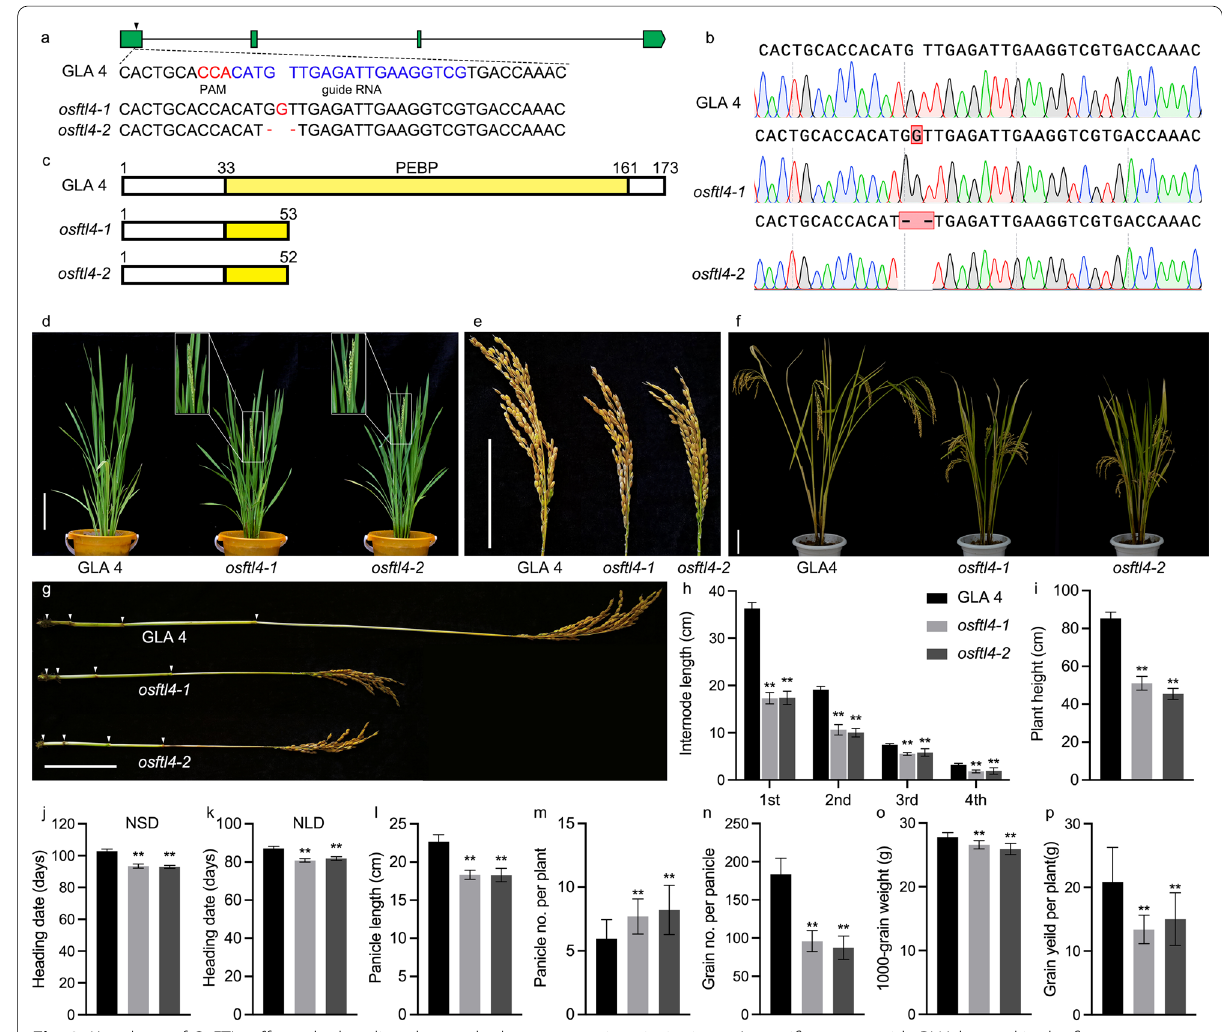
Fig. 2 Knockout of OsFTL4 affects the heading date and other agronomic traits in rice. a A specific target guide RNA located in the first exon was used to edit OsFTL4 via the CRISPR/Cas9 system. The PAM region and guide sequence are marked in red and blue, respectively. The OsFTL4 mutation sites in the two mutants ( osftl4-1 and osftl4-2 ) are indicated. b Mutations were confirmed by sequencing. Mutated bases are marked with red boxes. c OsFTL4 protein structures in GLA 4, osftl4-1 , and osftl4-2 . The PEBP domain is marked in yellow. d Morphology of GLA 4, osftl4-1 , and osftl4-2 plants at heading stage. Scale bars, 10 cm. e Panicle phenotype of GLA 4, osftl4-1 , and osftl4-2 . f Morphology of GLA 4, osftl4-1 , and osftl4-2 plants at maturity satge. Scale bars, 10 cm. g Panicle and internode at maturity. Scale bars, 10 cm. h Length of four internodes below the spike. Heading date for GLA 4, osftl4-1 , and osftl4-2 in Lingshui j and Yangzhou k . Comparison between GLA 4 and the mutants in terms of the plant height i , panicle length l , panicle number per plant m , grain number per panicle n , 1,000-grain weight o , and grain yield per plant p . Data are provided as the mean SD from 20 individual plants. Significant differences were determined according to Student’s t -test (**, p < ±